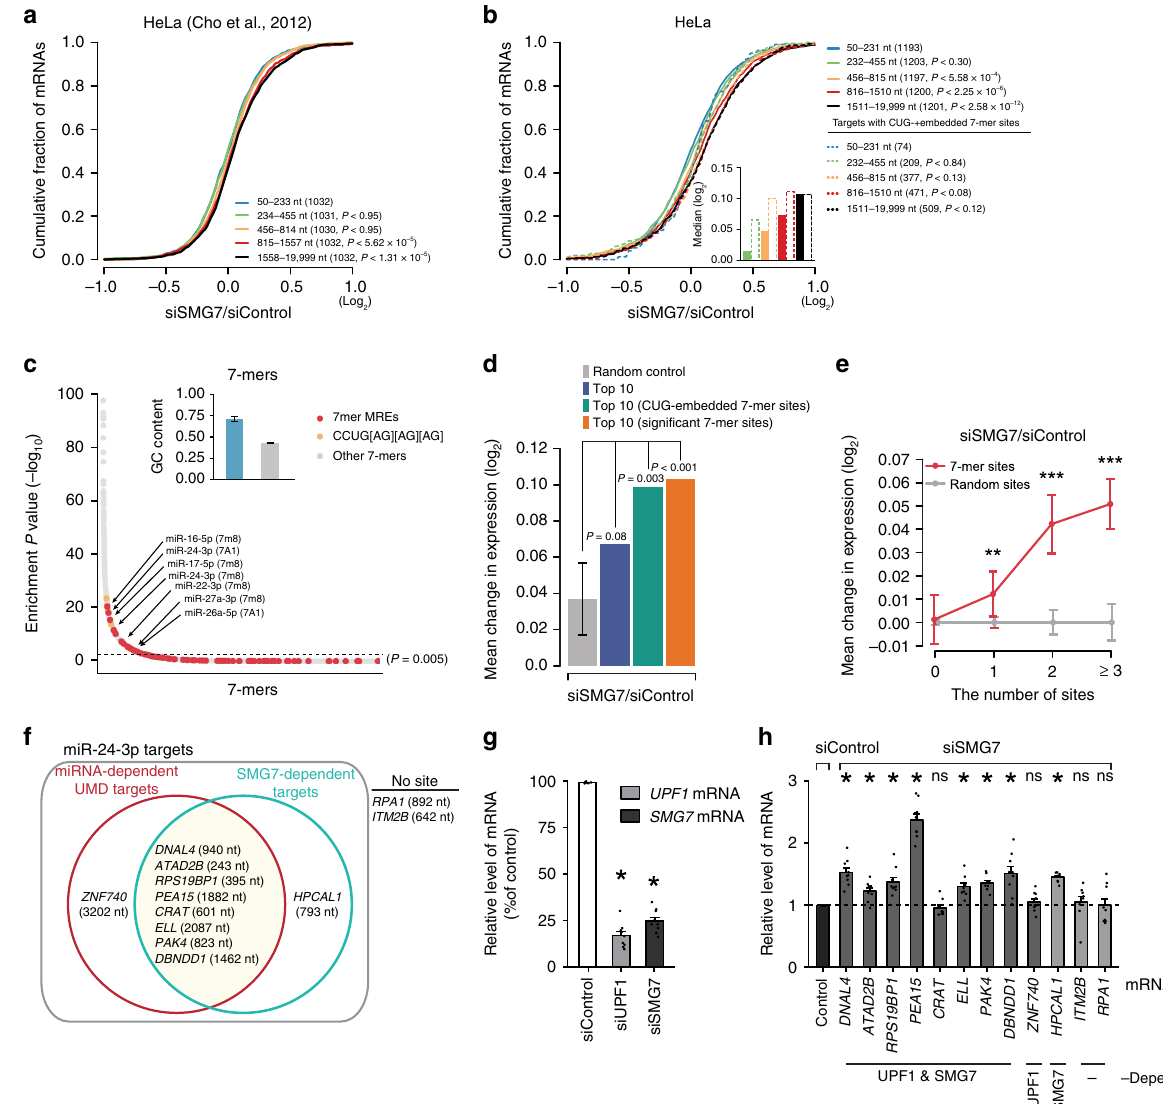
Fig. 6 Subset of miRNA-dependent UMD targets depends on SMG7. a CDFs for changes in the expression of dEJ-free mRNAs in microarray data prepared from siSMG7-treated and siControl-treated cells are shown. Otherwise, as in Fig. 1b – d. b as in ( a ), CDF graphs of changes in the expression of dEJ-free mRNAs (solid lines) and targets with CUG-embedded 7-mer sites of the 50 most abundant miRNA families (dotted lines) in siSMG7-treated and siControl-treated cells. Median expression fold-changes are depicted by box plots (inset). Blank boxes with a dotted line denote the median fold-changes of targets with CUG-embedded 7-mer sites. c Analysis of all possible 7-mers enriched in the 3 ′ UTR of SMG7-dependent mRNAs. Otherwise, as in Fig. 2a. d Mean changes in expression of a random control (gray), dEJ-free mRNAs with 7-mer sites (blue), targets with CUG-embedded 7-mer sites (green), or targets with signi fi cant 7-mer sites (orange) of the ten most abundant miRNA families in siSMG7-treated versus siControl-treated cells. Otherwise, as in Fig. 3a. e Mean changes in expression of dEJ-free mRNAs in SMG7-knockdown versus control cells are shown over different numbers of miRNA sites (red) or random sites. Asterisks denote statistically signi fi cant differences ( ** P < 0.01; *** P < 0.001; K – S test). Otherwise, as in Fig. 3f. f Venn diagram of nine selected miRNA-dependent UMD target candidates in Fig. 4a and nine SMG7-dependent targets. The values in parentheses are the lengths of the 3 ′ UTR in each transcript. “ No site ” indicates that the mRNAs did not contain any putative miRNA sites of the 50 most abundant miRNAs. g Endogenous UPF1 and SMG7 in HeLa cells were depleted by siRNA-mediated downregulation. RT-qPCR was performed to examine the ef fi ciency of downregulation. The level of mRNA was normalized to that of GAPDH mRNA. h As in g ; however, the levels of transcripts listed in f were examined by RT-qPCR. Mean values and s.e.m. were calculated from independent experiments. (* P < 0.05; unpaired Student ’ s t test); ns not signi fi cant. The minimum number of independent biological replicate experiments was n = 9 in g , h